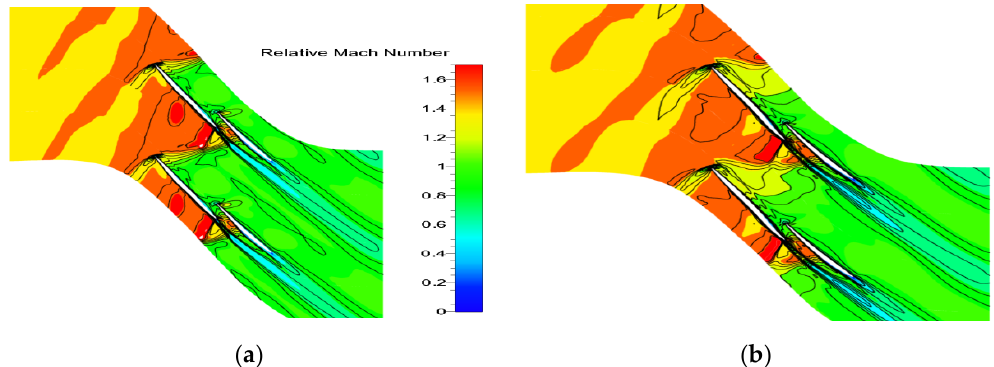
Figure 13. The relative Mach number of 90% span of the original and optimized tandem rotor. ( a ) ORG; ( b ) OPT.